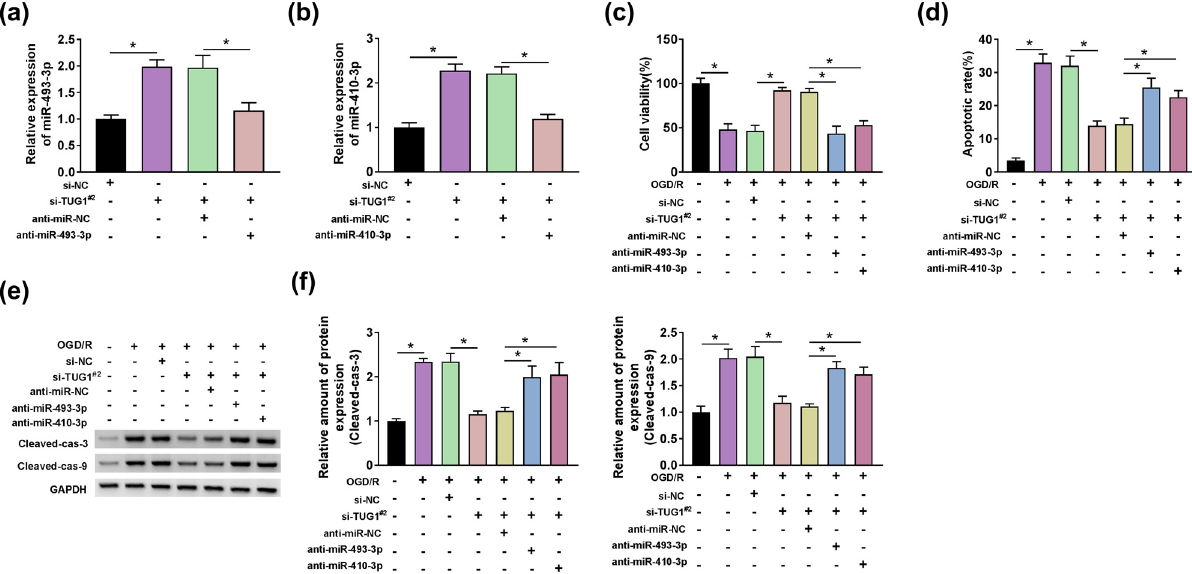
Figure 5: The inhibition of miR - 493 - 3p or miR - 410 - 3p could restore the reverse e ff ects of TUG1 knockdown on OGD/R - mediated decrease in viability and increase in apoptosis in N2a cells in vitro . ( a and b ) The e ff ect of si - TUG1 #2 and anti - miR - 493 - 3p or anti - miR - 410 - 3p on the expression of miR - 493 - 3p or miR - 410 - 3p was detected by RT - qPCR. ( c ) The e ff ect of si - TUG1 #2 and anti - miR - 493 - 3p or anti - miR - 410 - 3p on cell viability was evaluated by CCK - 8 assay in N2a cells treated by OGD/R. ( d ) Flow cytometry assay was applied to detect the apoptosis rate in N2a cells, which transfected with si - TUG1 #2 + anti - miR - 493 - 3p or si - TUG1 #2 + anti - miR - 410 - 3p or negative controls, with or without being treated by OGD/R. ( e and f ) The proteins levels of apoptosis - related markers ( cleaved - cas - 3 and cleaved - cas - 9 ) were performed by western blot assay in N2a cells, which transfected with si - TUG1 #2 + anti - miR - 493 - 3p or si - TUG1 #2 + anti - miR - 410 - 3p or negative controls, with or without being treated by OGD/R. * P <